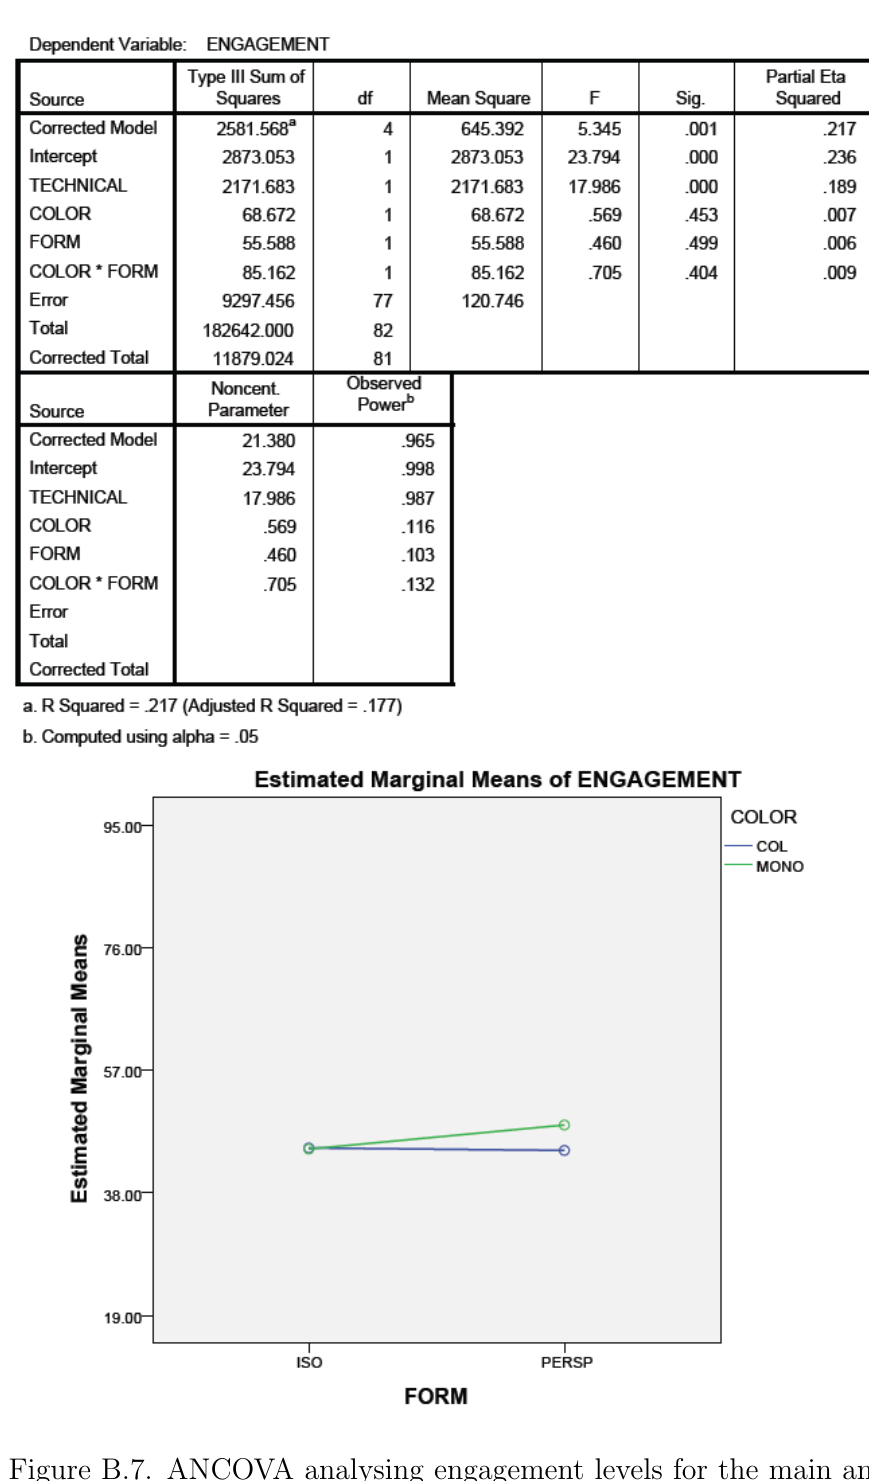
Figure B.7. ANCOVA analysing engagement levels for the main and interaction effects of color and form using data adjusted for technical